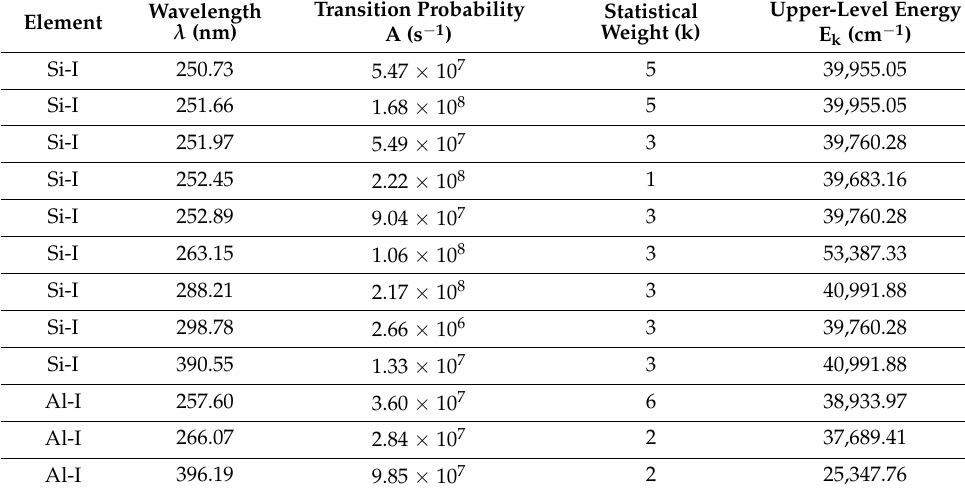
Table 3. Spectroscopic parameters of selected lines of Si-I and Al-I used for quantitative analysis of topaz crystals using the CF-LIBS method.